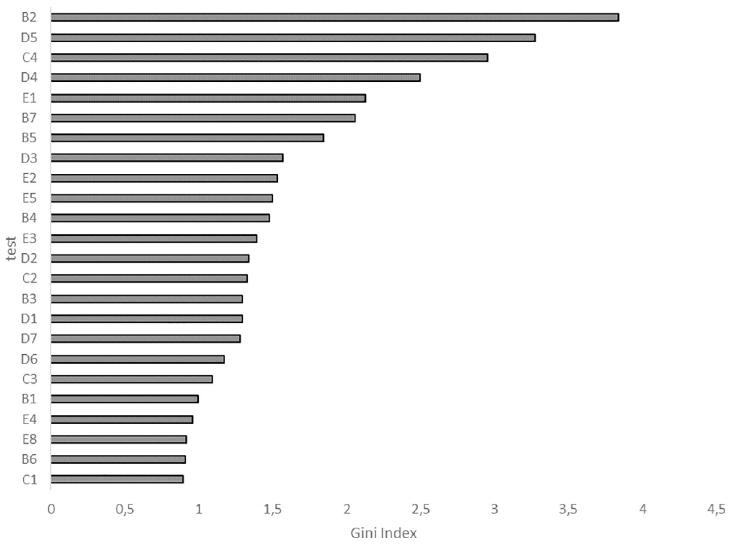
Fig 2. Path of data